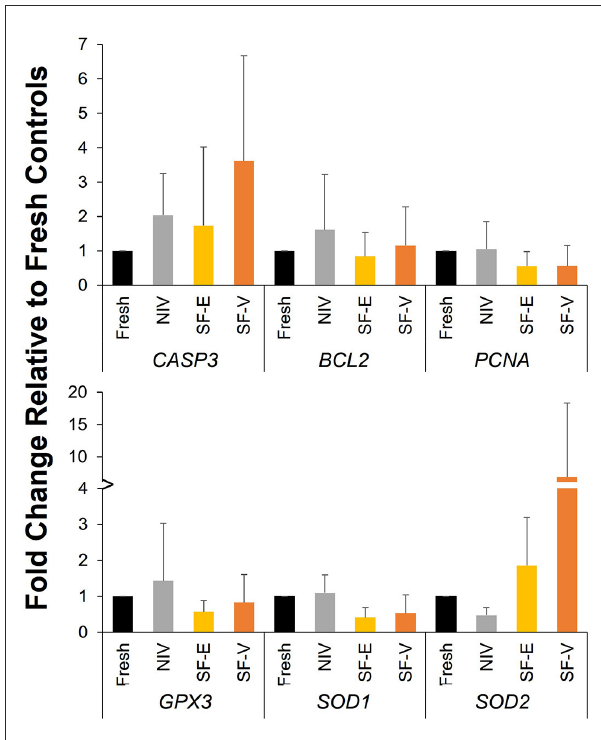
FIGURE5 Gene expression in cryopreserved-warmed [ via needle immersed vitrification (NIV), or slow freezing with either 7.5% DMSO and EG (SF-E), or 15% DMSO and EG with 0.5M sucrose (SF-V)] African painted dog ovarian tissue relative to Fresh controls ( n = 4). Y axis represents the fold change (mean ± standard deviation) in gene expression relative to Fresh controls.